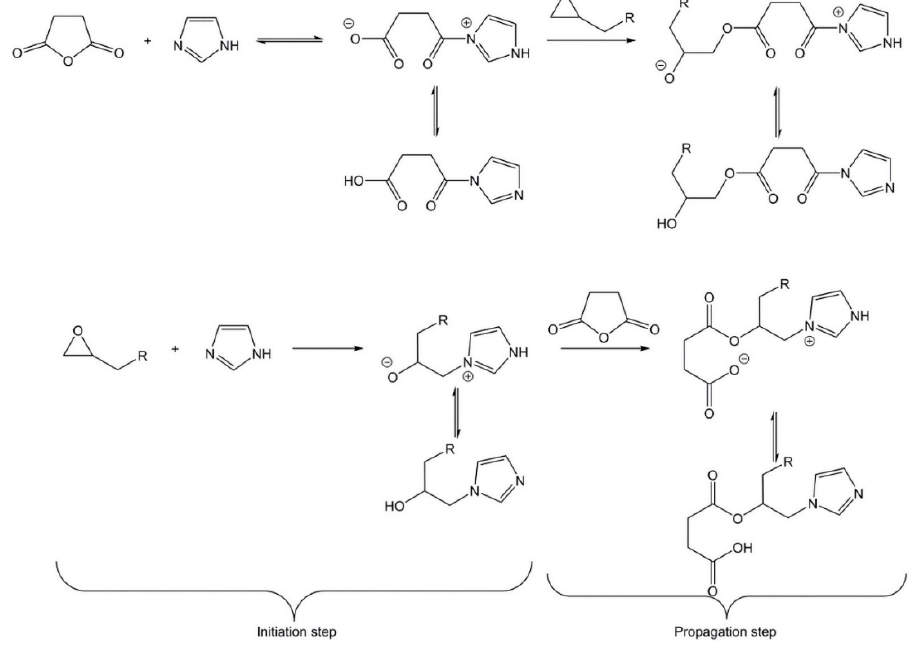
Scheme 3. Curing mechanism of succinic anhydride and epoxides initiated by